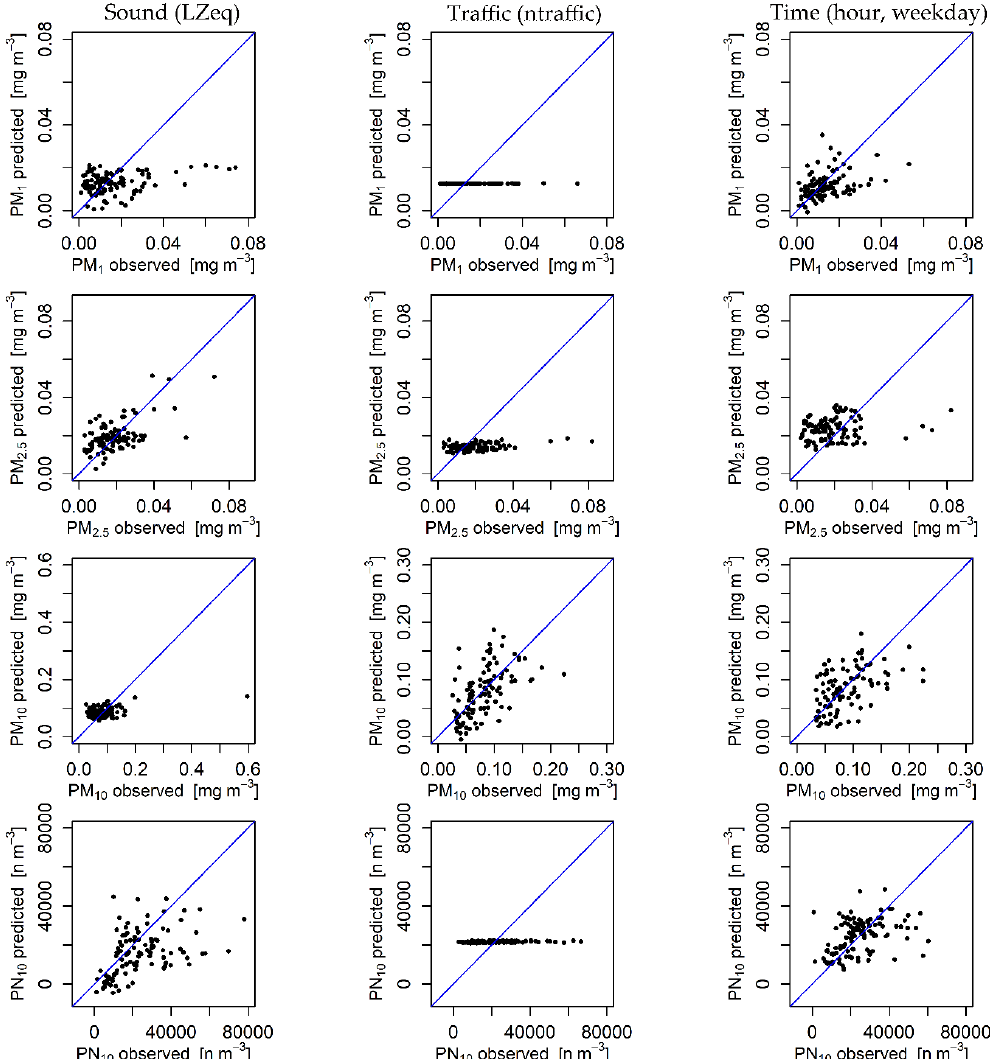
Figure 6. Scatter plot diagrams of aerosol particle predictions and observations for three input variable options (sound, traffic and time). The blue line illustrates a 1:1 match between the modelled and observed values.